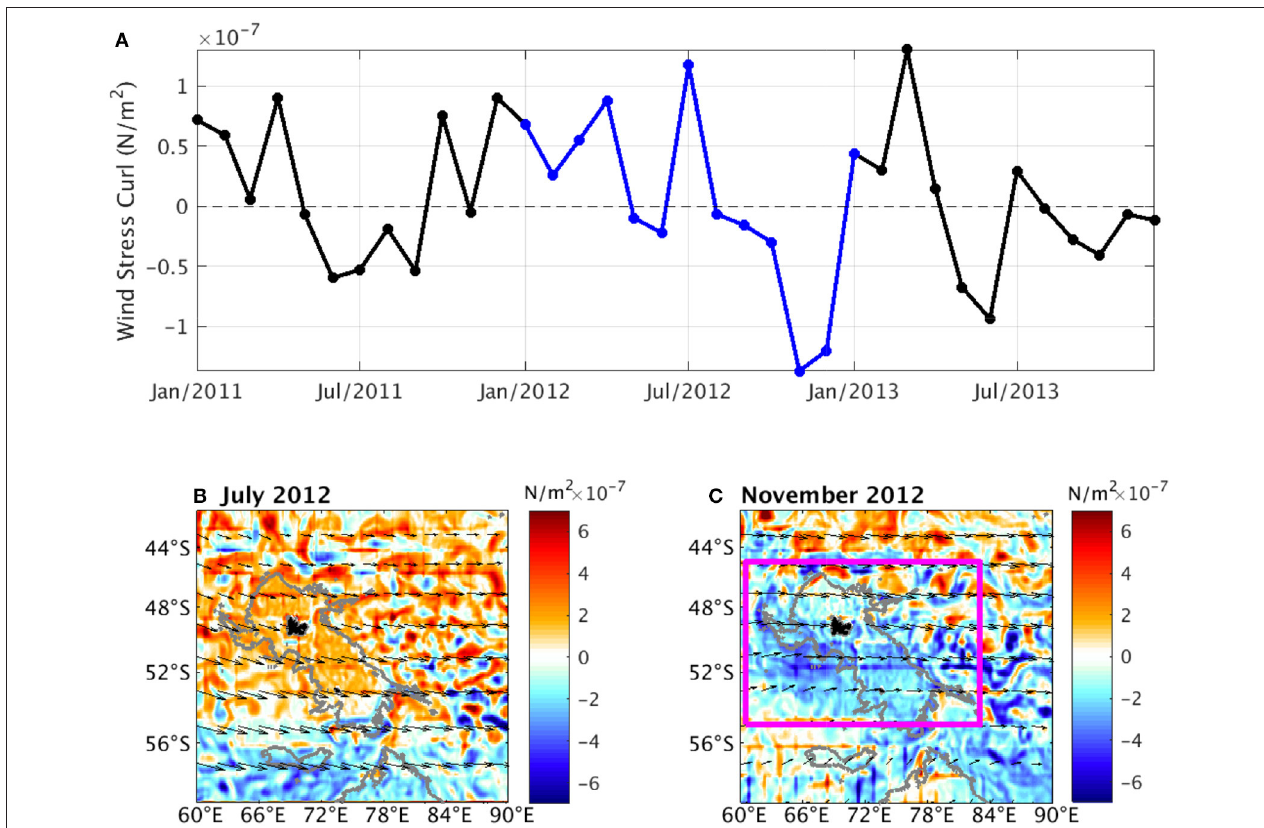
FIGURE 6 | (A) Time-series of spatially averaged wind stress curl in the region delimited by the magenta box in (C) , between January 2011 and December 2013. The blue line indicates the year 2012; (B,C) maps of wind stress curl (colors) and wind stress (arrows) in July 2012 and November 2012, respectively. The gray line is the 3,000 m